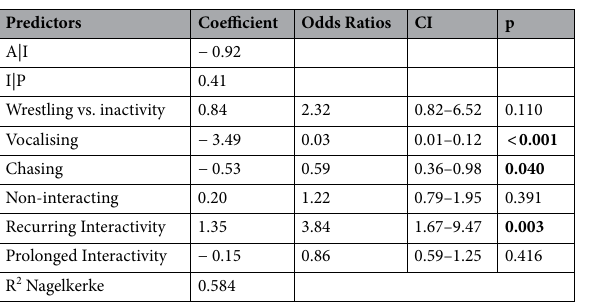
Table 6. Ordinal regression of expert labels onto factor scores. Significant values are in